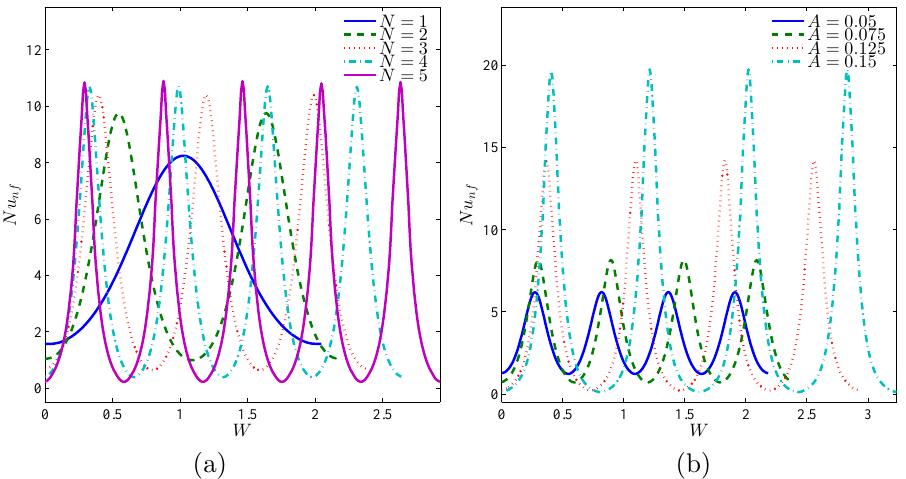
Figure 10. Variation of local Nusselt number interfaces with the wavy W for different ( a ) N and ( b ) A at Ra = 10 6 , and φ =